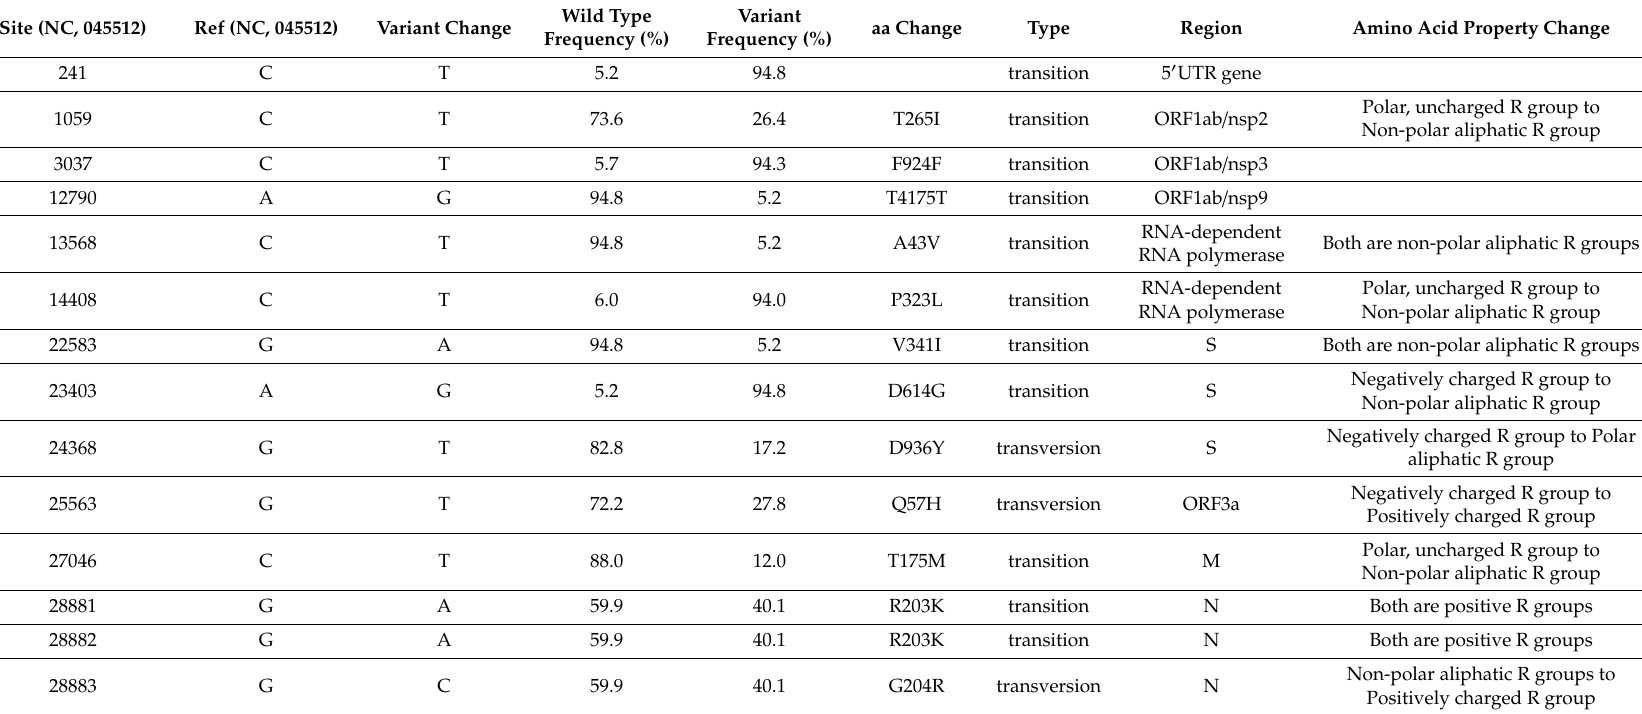
Table 1. Observed mutations and the